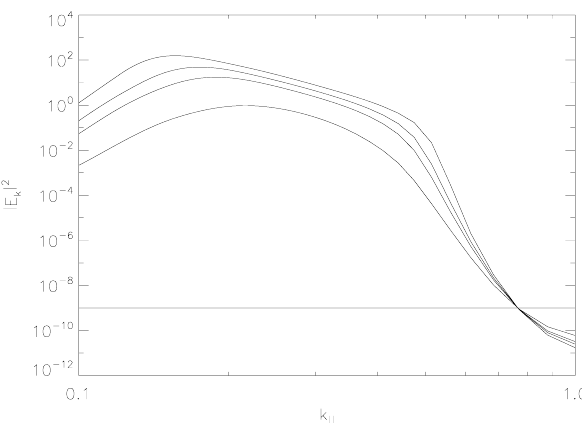
Fig. 3. Spectral density of the lower hybrid waves as function of the parallel wave number at times t = ( 0 ; 2 . 2 × 10 3 ; 2 . 7 × 10 3 ; 2 . 9 × 10 3 ; 3 . 2 × 10 3 ) 1 for S2 set of parameters. ω ce